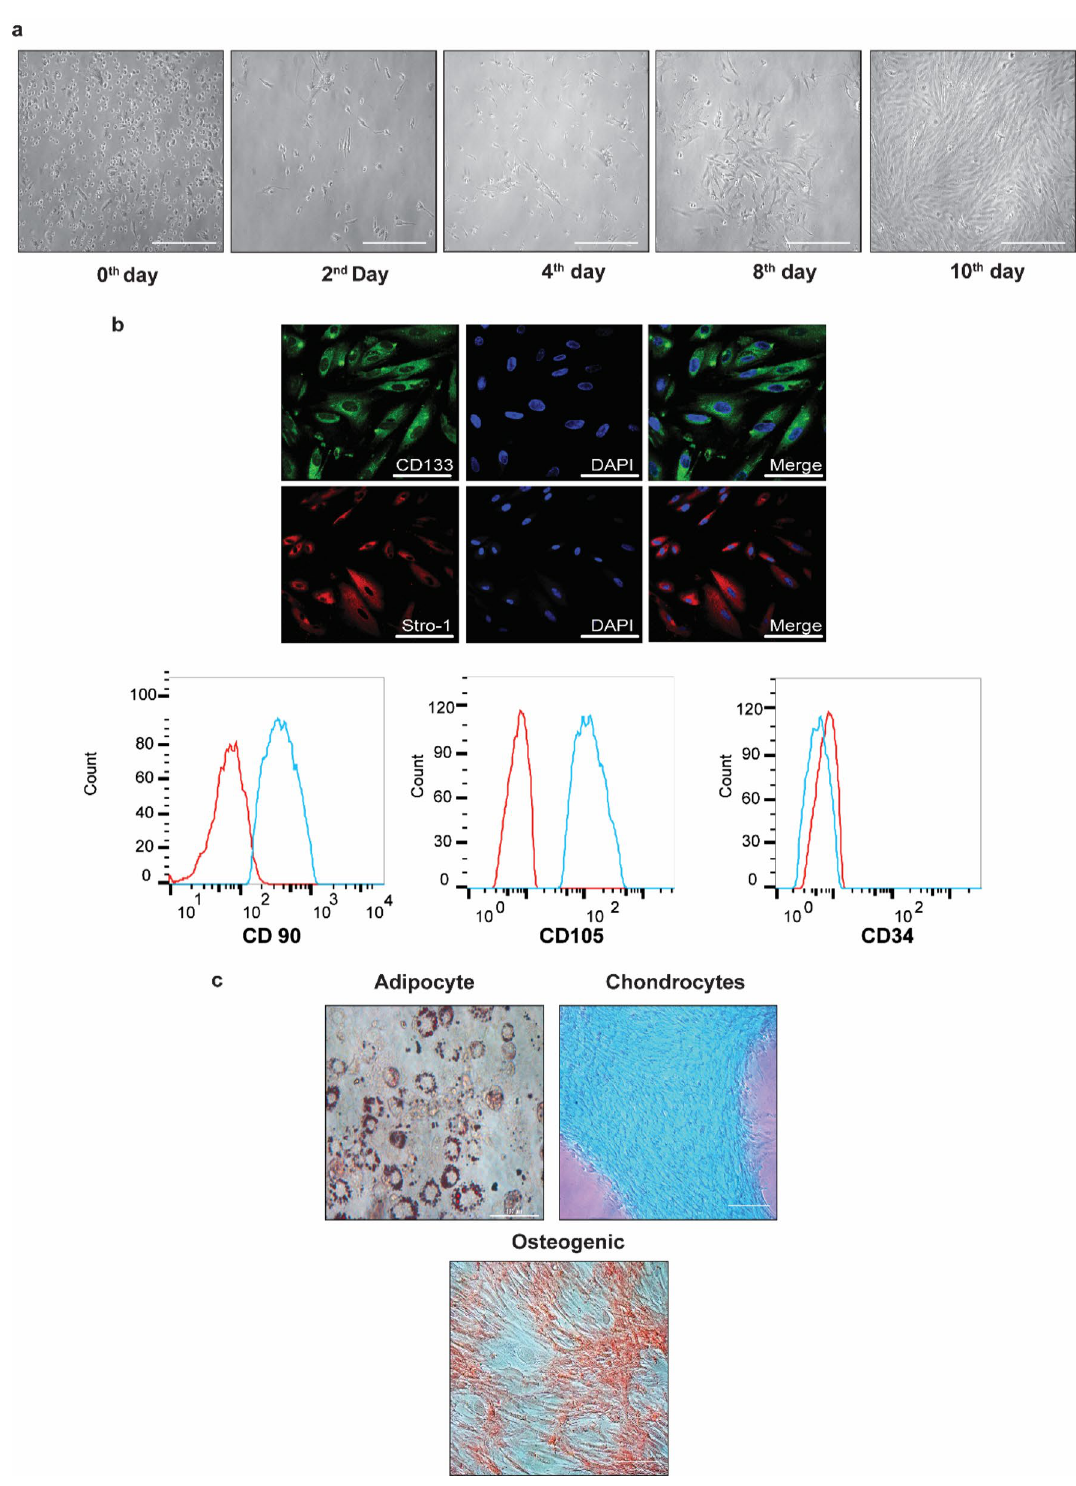
Figure 1. Morphology of placental-derived mesenchymal stem cells in primary cultures. ( a ) Bright-field images taken at the indicated time points showing the heterogeneous population’s formation to a homogenous population of human placental mesenchymal stem cells (P-MSCs). ( b ) Representative confocal images of human P-MSCs showing positive staining for CD133 and Stro-1 stem cell markers. The nuclei were stained with DAPI, and a representative flow cytometer histogram of P-MSC for markers CD90, CD105, and CD34. ( c ) Representative microscopic images showing the differentiation of P-MSCs under various growth conditions. The presence of lipid droplets indicates adipogenic differentiation. Chondrogenic differentiation was demonstrated by the formation of Alcian blue positive pellets. Alizarin Red detected calcium depositions to show osteogenic